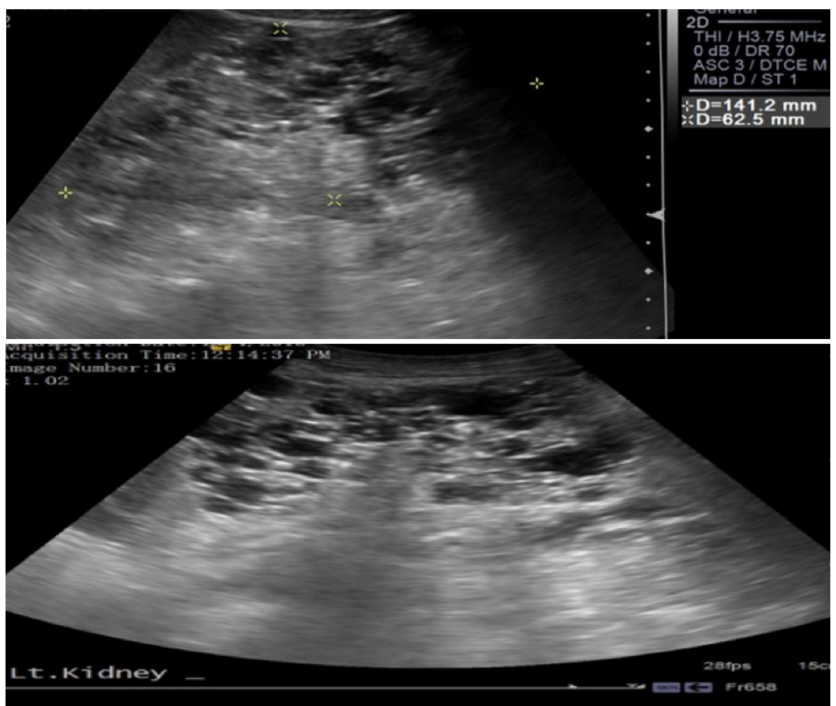
Figure 3: Ultrasound imaging reveals that both kidneys are enlarged with multiple cysts and loss of normal architecture, sugges- tive of polycystic kidney